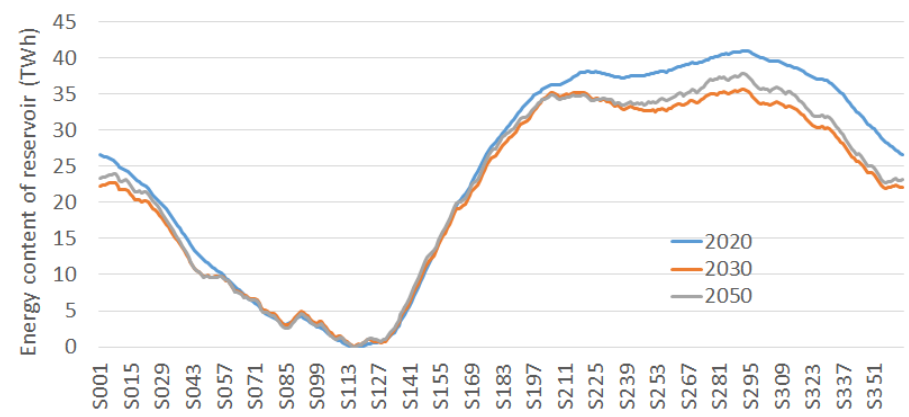
Figure 4. Planned energy content (TWh) along the year of hydro reservoirs in Norway at the beginning of each season, i.e., day. The minimum value of each profile has been subtracted.